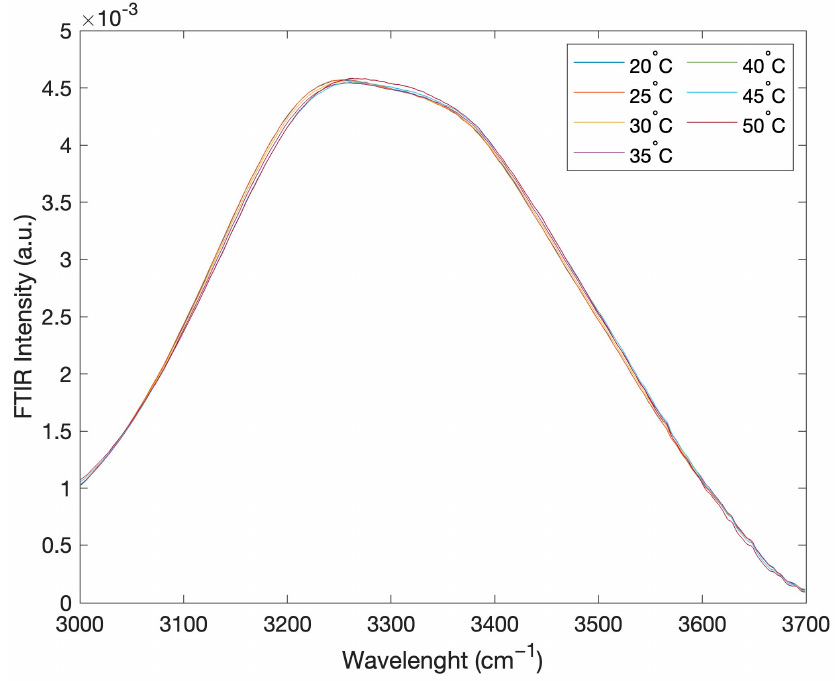
Figure 3. FTIR intramolecular OH stretching band for the concentration value of 50% glucose and 50% water, as a function of temperature.